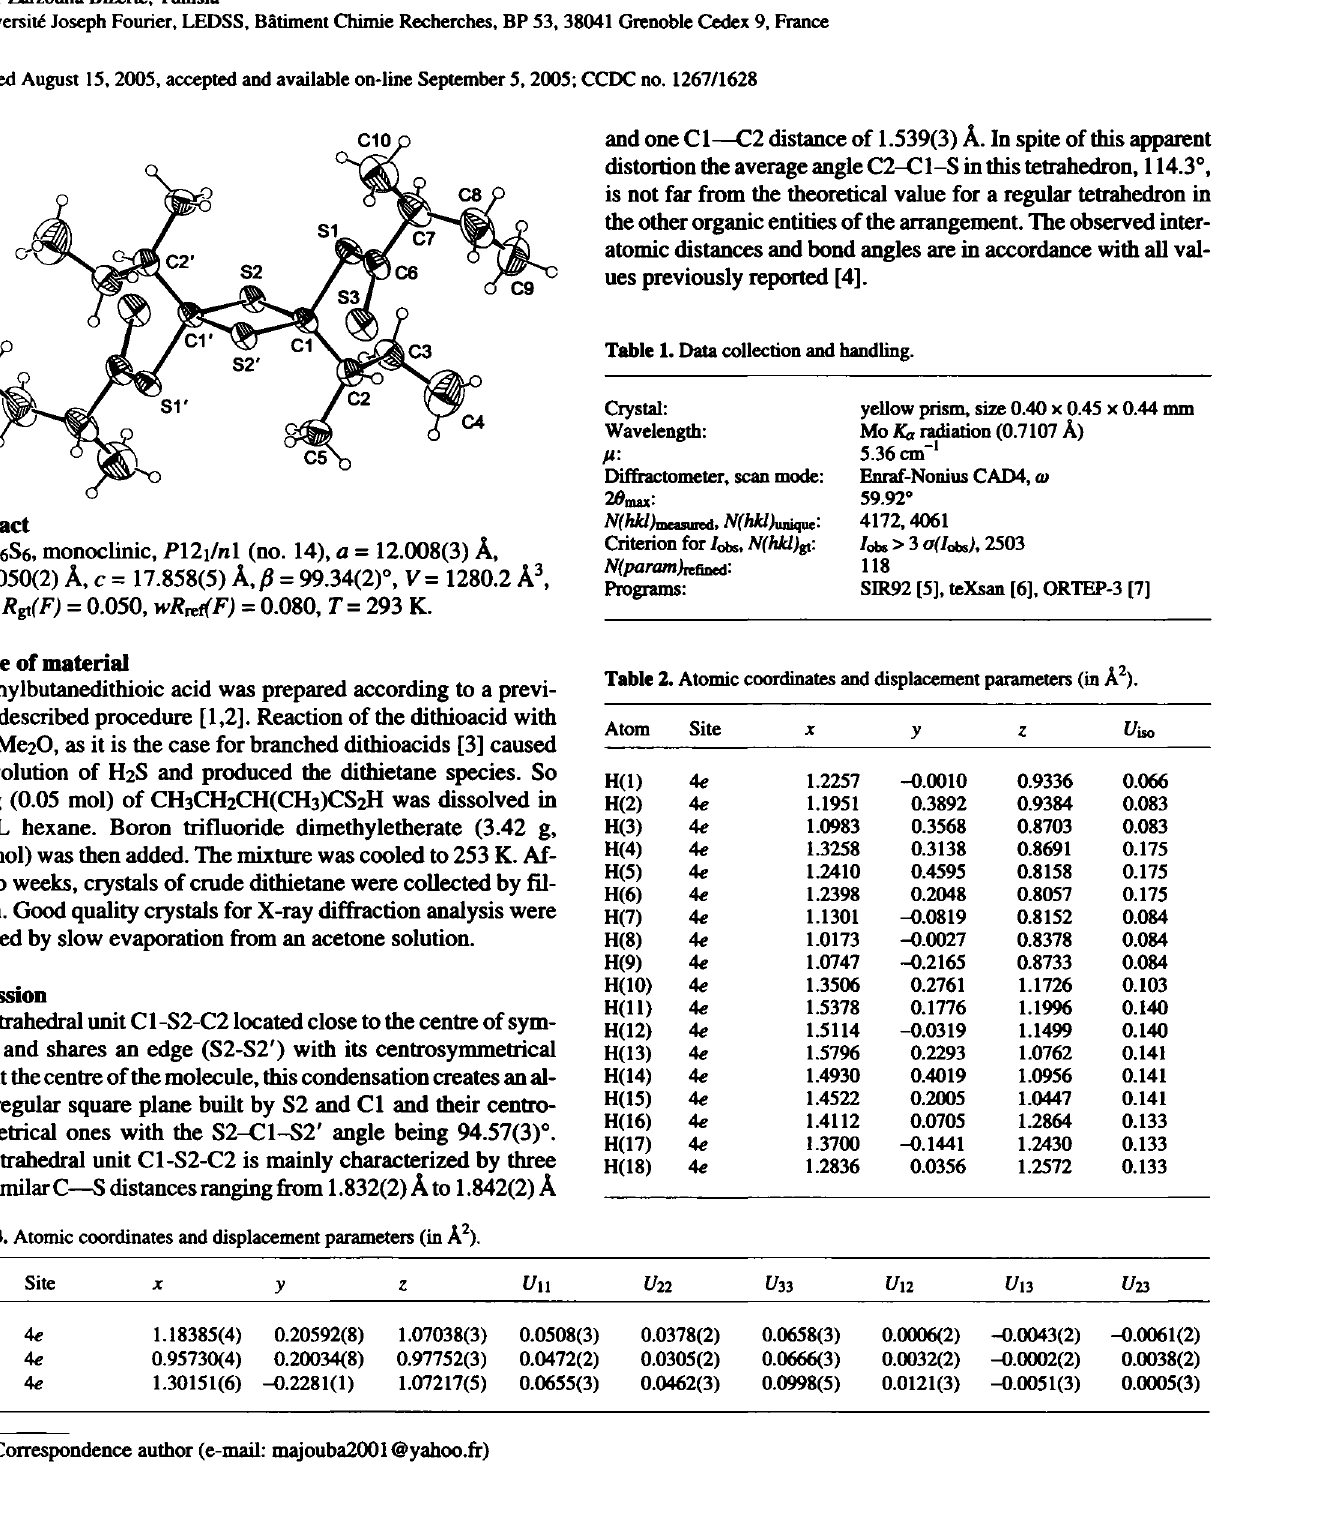
Table 1. Data collection and handling.